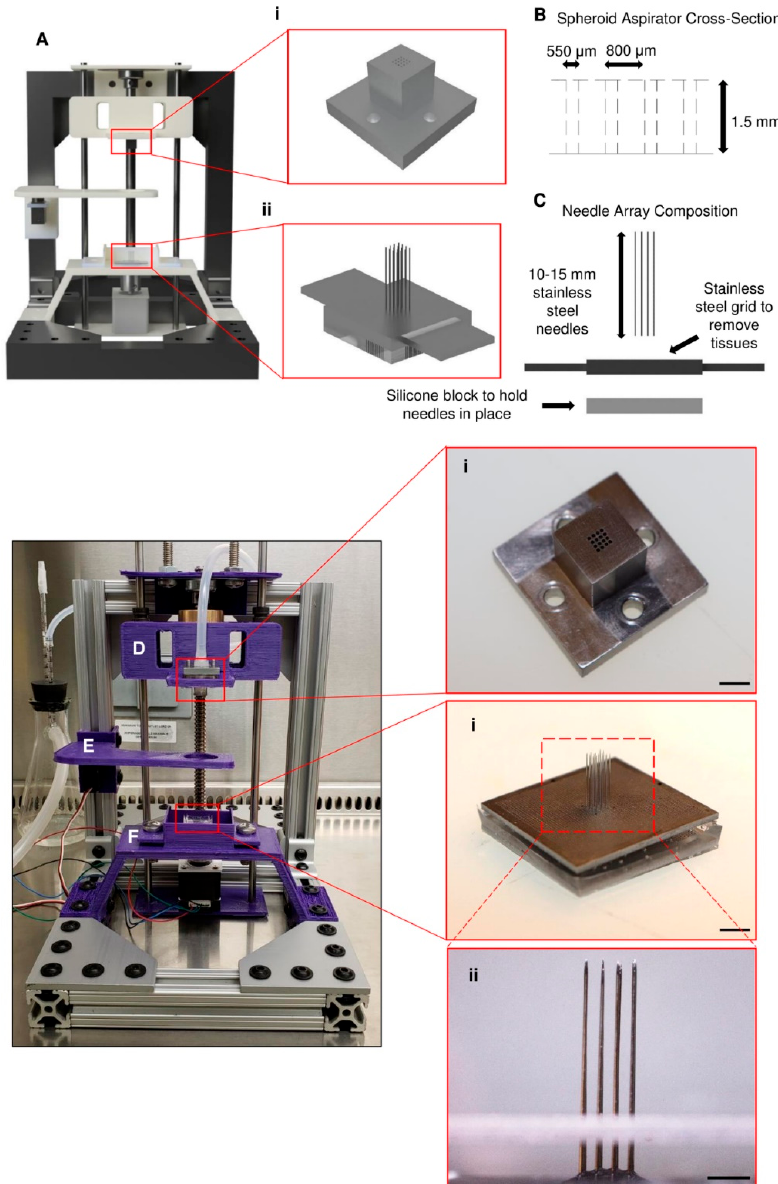
Figure 1. Design and construction of the bioprinter and its components. ( A ) A model of the bioprinter